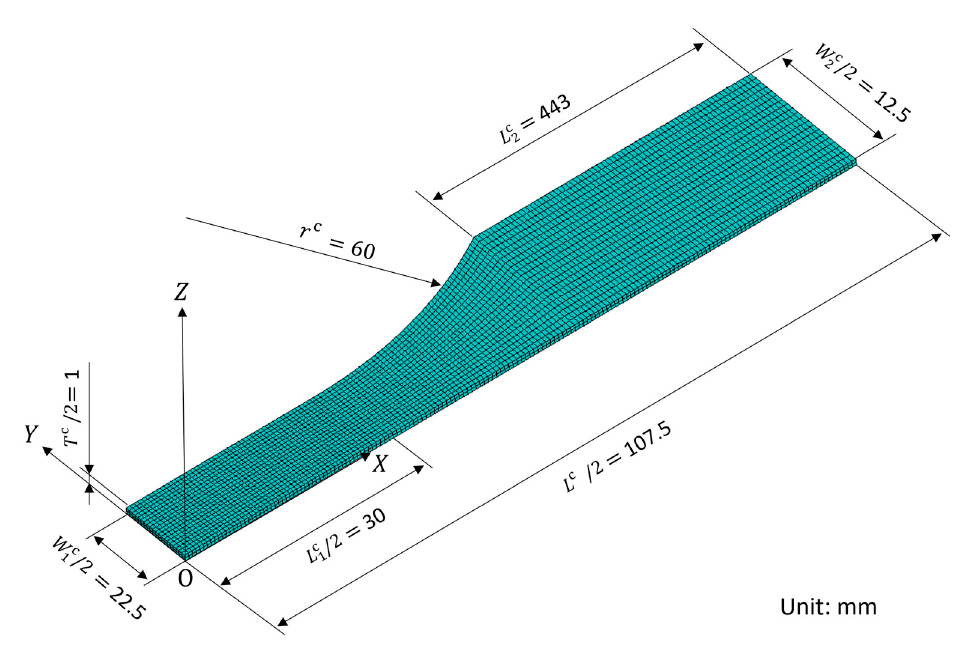
Figure 3. One-eighth finite element model of tensile specimen.